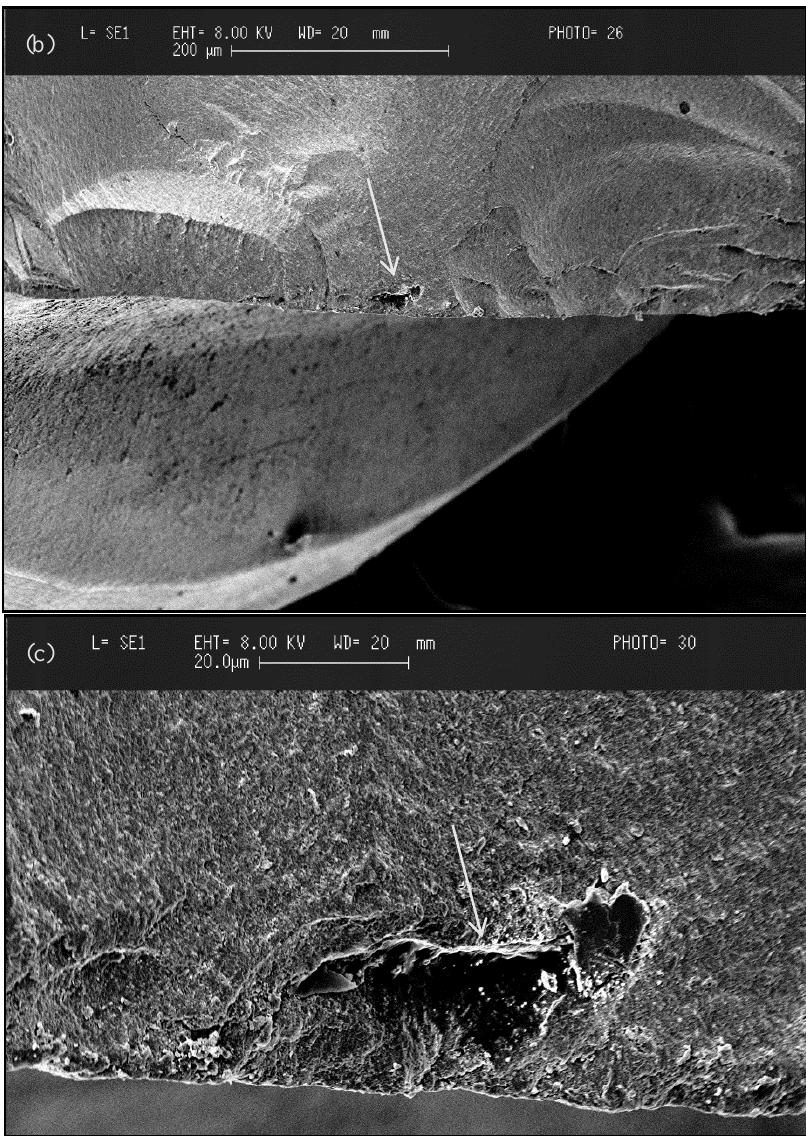
Figure 3. SEM images at different magnifications of various fractured zirconia implants showing porosities (white arrows) pointed out as the cause of implant fracture: ( a ) magnification factor: ×250; ( b ) magnification factor: ×500; ( c ) magnification factor: